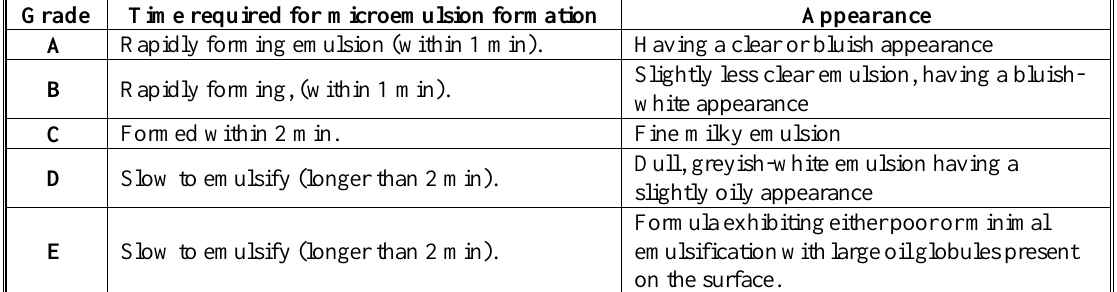
Table 2. Grading system of in-vitro performance of self-microemulsifying drug delivery system (dispersibility and self-microemulsification